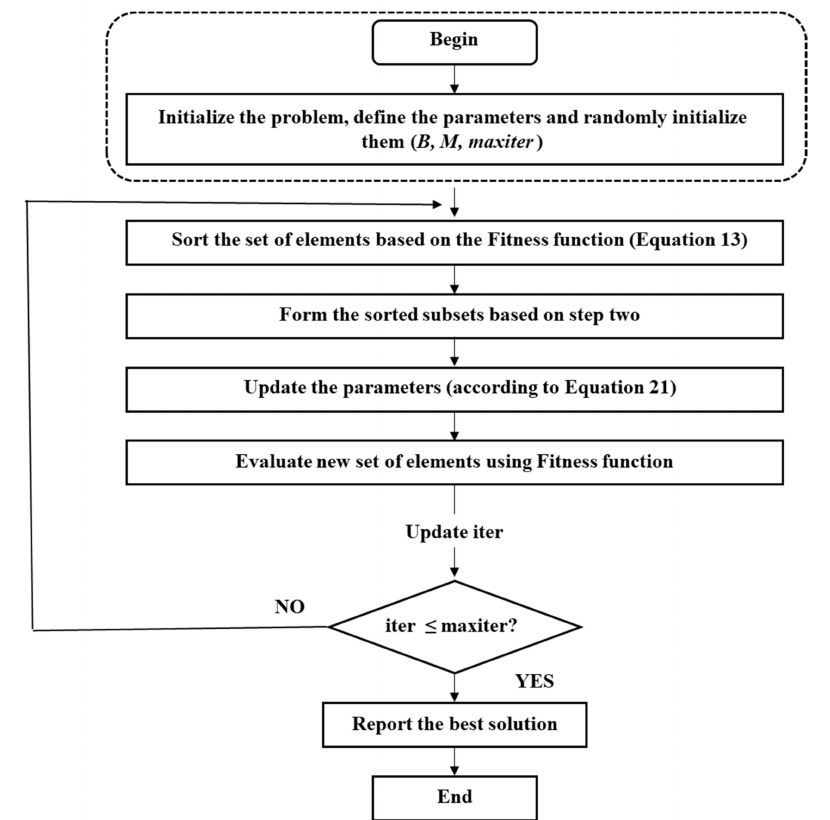
Figure 3. Pseudo code of developed bird search-based shuffled shepherd optimization algorithm